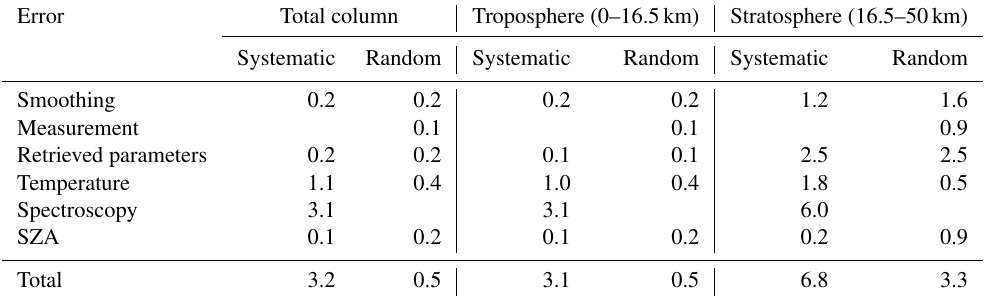
Table 5. The systematic and random uncertainties for the SFIT4NIR-retrieved CH 4 total column, partial columns in the troposphere (0– 16.5km) and in the stratosphere (16.5–50km). The uncertainties are shown in percentages (%). The empty field shows where the uncertainty is negligible, with a value of less than 0.1%. Error Total column Systematic Random Systematic Random Systematic Random Smoothing 0.2